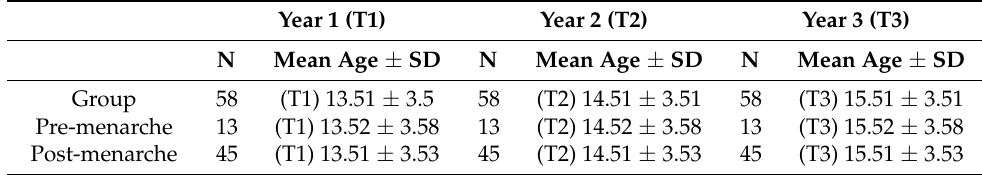
Table 1. Descriptive characteristics of the pre- and post-menarche groups.